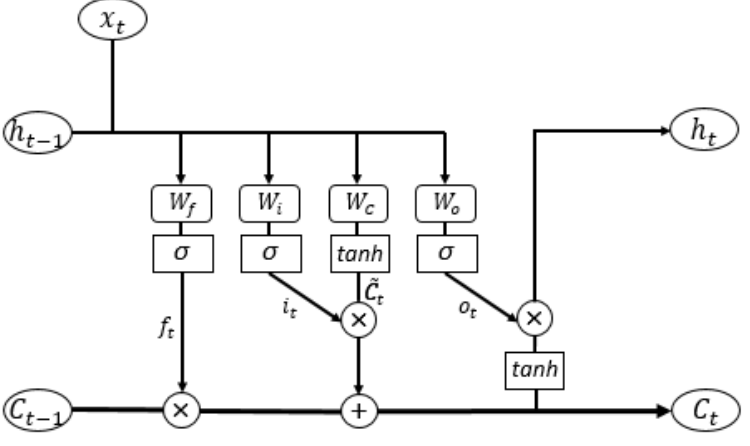
Figure 1. Structure of the long short-term memory (LSTM) repeating module.